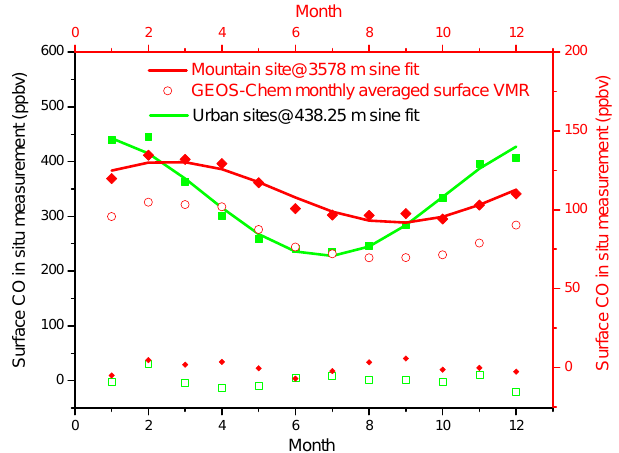
Figure 7. Monthly averaged CO surface VMR at Wollongong from in situ measurements (black open squares) and the GEOS-Chem model (black full circles) from June 2012 to May 2013. The sine function fit residuals are shown in the bottom